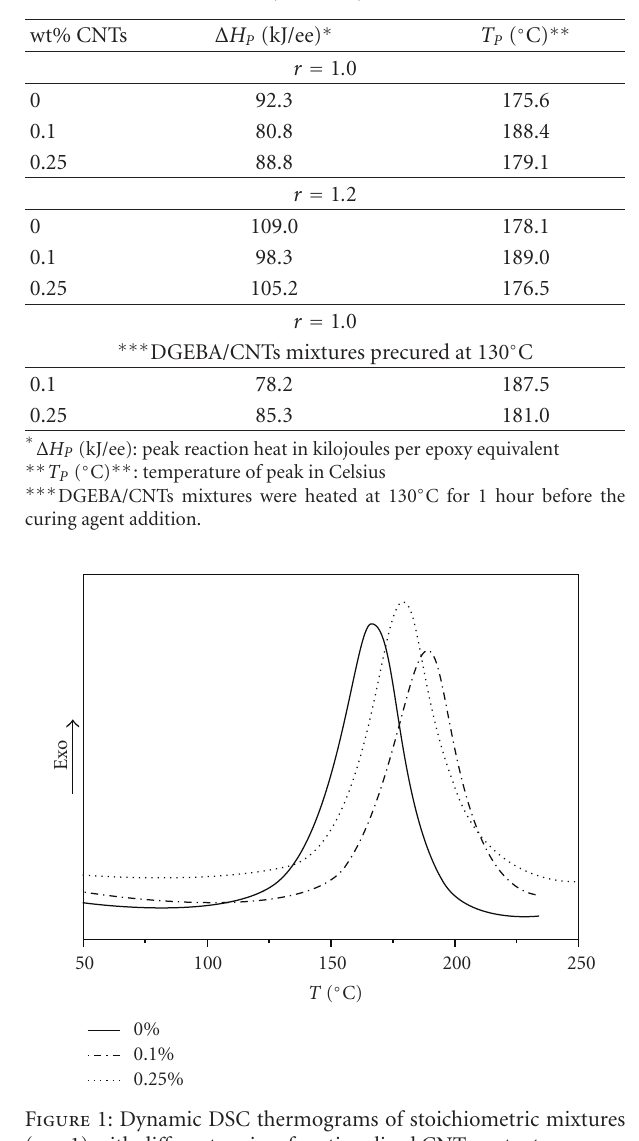
Table 1 collects a summary of the dynamic DSC